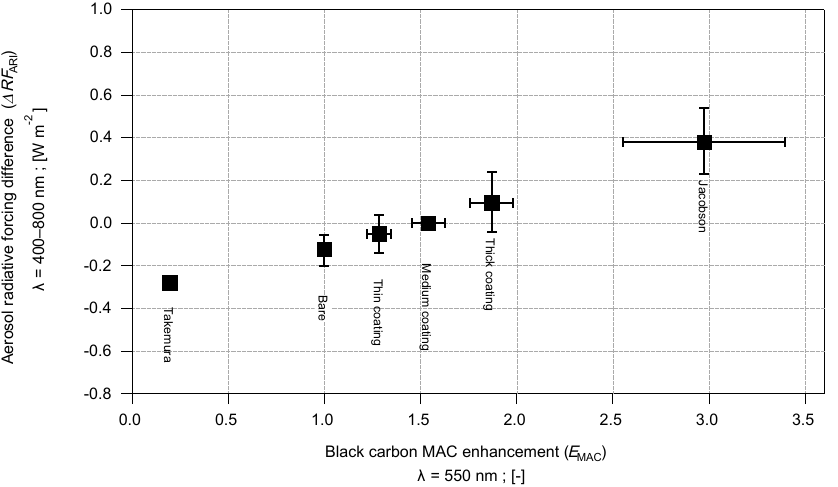
Figure 8. Dependence of radiative forcing difference ( (cid:49) RF ARI ) on black carbon MAC enhancement ( E MAC ) due to the lensing effect for different BC mixing state scenarios. (cid:49) RF ARI is the difference in aerosol radiative forcing at the top of the atmosphere between the scenario of interest and the base case scenario. Negative (cid:49) RF ARI values thus indicate a reduction of the radiative forcing compared to the base case scenario. “Medium coating” is the base case scenario reflecting the median of the measured coating thickness values, while the “thin” and “thick” scenarios reflect the 25th and 75th percentiles, respectively. The points “Jacobson” and “Takemura” reflect the extreme values applied in previous global model simulations (Jacobson, 2012; Takemura et al., 2000, 2002, 2005). Vertical error bars represent the variability introduced by the standard deviation of the single-scattering albedo during the campaign. Horizontal error bars represent the campaign standard deviation of E MAC